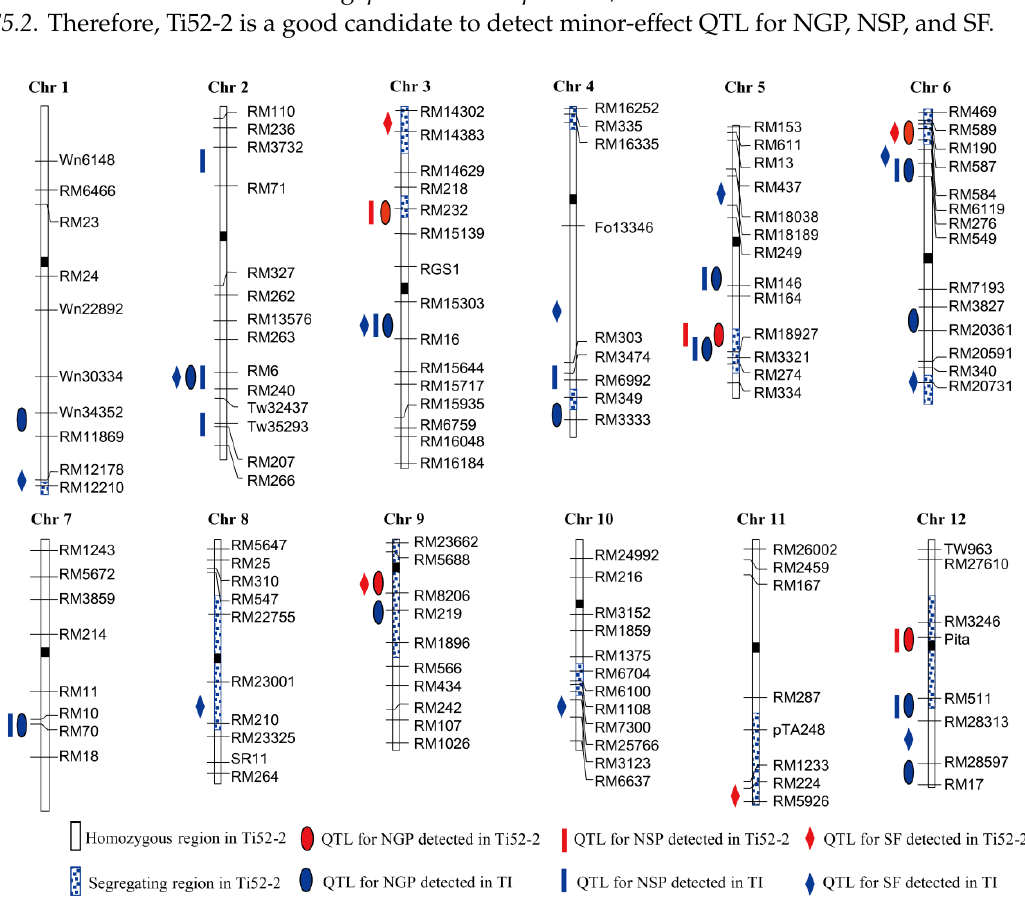
Figure 4. Distribution of QTLs for NGP, NSP, and SF detected in Ti52-2 and TI populations.